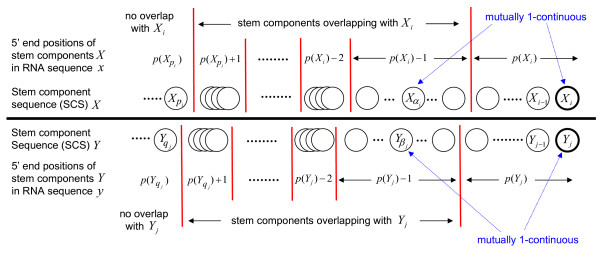
An example of relations of indices of stem components in SCS alignment. αi/βj and pi/qj in equation (1) are the indices (smaller than i/j) of stem components of X/Y. The red lines separate the stem components into groups which have the same positions in RNA sequences. When Xi and Yj match in DP of SCS alignment, the stem components of the adjacent previous match must be either non-overlapping or 1-continuous with Xi/Yj. Xαi/Yβj are 1-continuous with Xi/Yj. Xpi/Yqj are the nearest stem components that do not overlap with Xi/Yj.